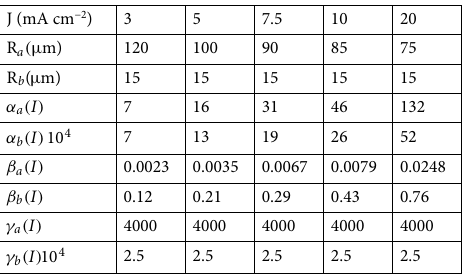
Table 2. Modelling parameters for the nickel electrode.